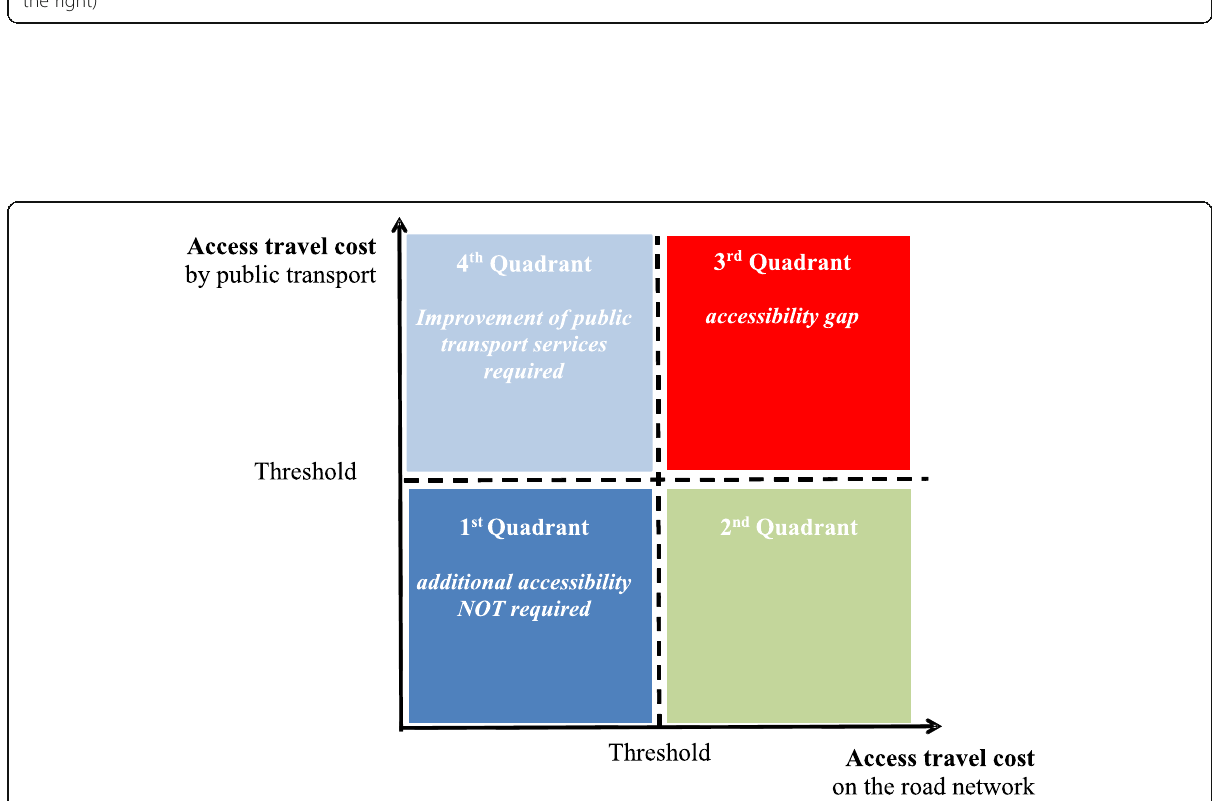
Fig. 5 travel times from the main railway stations to the selected tourist sites, on the road network (on the left) and using public transport (on the right)